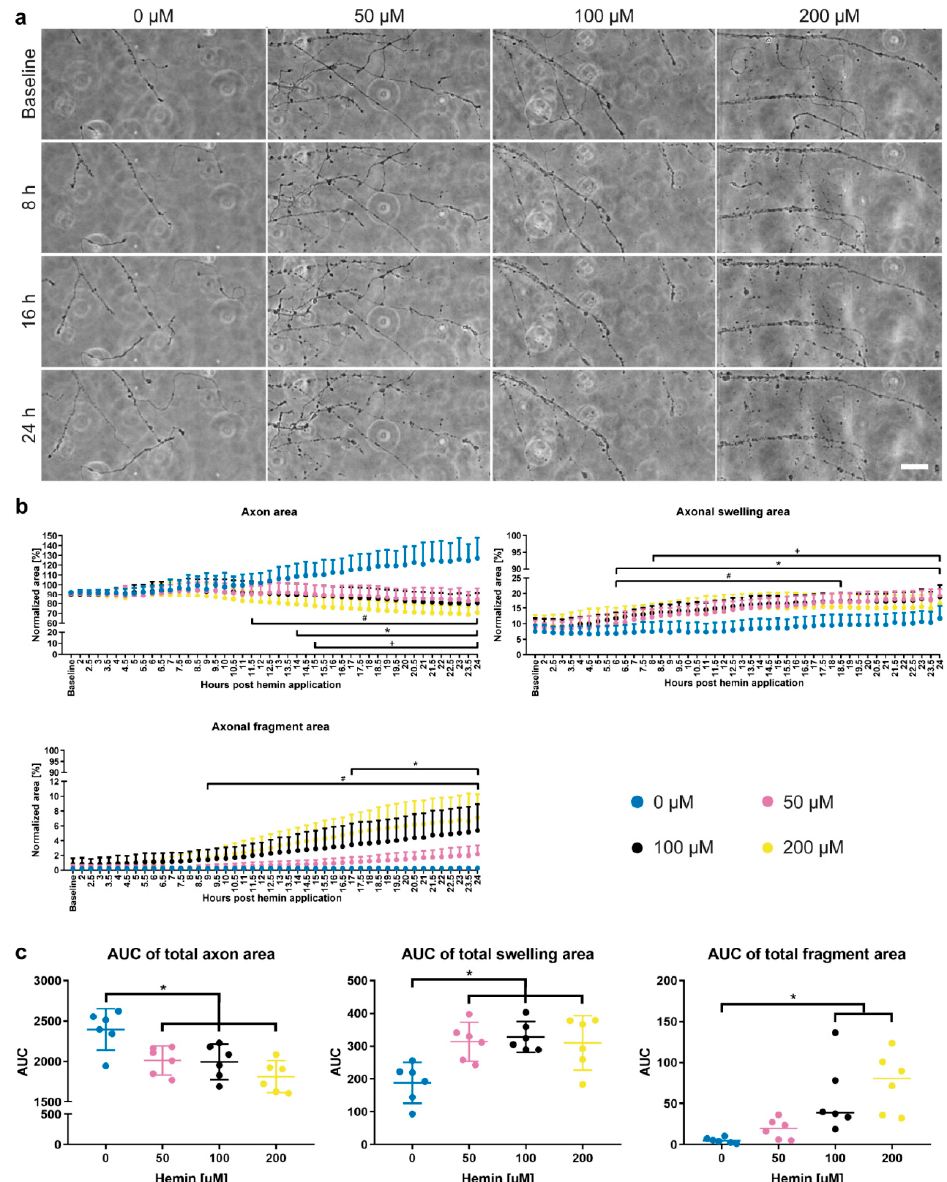
Figure 4. Time-dependent hemin-induced AxD. ( a ) Primary cortical axons treated with hemin (50, 100, 200 µ M) degenerated compared to vehicle-treated axons (0 µ M) that continued to grow. Scale bar: 50 µ m. For complete time-lapse videos including segmentation, refer to Videos S1–S4. ( b ) Quantification of AxD over 24 h in phase-contrast images. To determine the time course, the sum of pixels in each class and hemin concentration over time was normalized to the baseline of that class and condition. The quantification of the phase-contrast images over 24 h revealed significantly smaller axon areas starting at 11.5 h after 200 µ M ( P = 0.020), at 14 h after 100 µ M ( P = 0.040), and at 15 h after 50 µ M ( P = 0.018) hemin treatment compared to the control (0 µ M). The axonal fragment area significantly increased from 9.5 h onwards in 200 µ M hemin ( P = 0.037) and from 17.5 h in 100 µ M hemin ( P = 0.044), while the axonal swelling area increased from 6 h onward in 100 µ M hemin ( P = 0.019) and 200 µ M hemin ( P = 0.010), and from 8 h in 50 µ M hemin ( P = 0.030). N = 6 independent cultures of primary cortical neurons. Means + 95% CI are given. One-way ANOVA with Greenhouse-Geisser correction. +, *, # P < 0.05; + = 50 µ M vs. 0 µ M, * = 100 µ M vs. 0 µ M, # = 200 µ M vs. 0 µ M. For detailed statistical information, refer to Table S3. ( c ) Area-under-the-curve (AUC) analysis of hemin-induced AxD. Whereas axons exposed to hemin showed a decline in axon area, axonal swelling and axonal fragment area increased over 24 h. N = 6 independent cultures of primary cortical neurons. Means ± 95% CI are given for axon and axonal swelling area, medians for fragment area. * P < 0.05 vs. 0 µ M. For exact P values, refer to Table